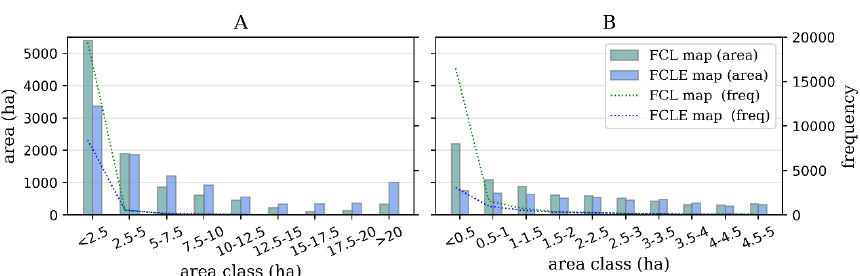
Figure 5. Area distribution of the harvesting site representations on the original FCL map and the enhanced map (FCLE). The results are shown for the whole data set ( A ), and a subset of the areas under 5 ha ( B ). The difference between the green and blue bar-pairs shows the impact of the elimination of fragmented features and aggregation of features into contiguous harvested site representations. Frequency refers to the number of polygons represented within each area class.